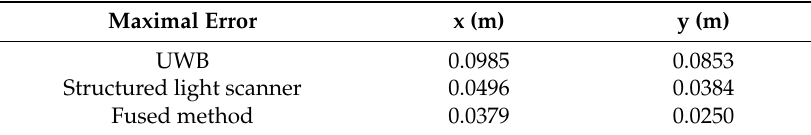
Table 5. Maximal errors for different